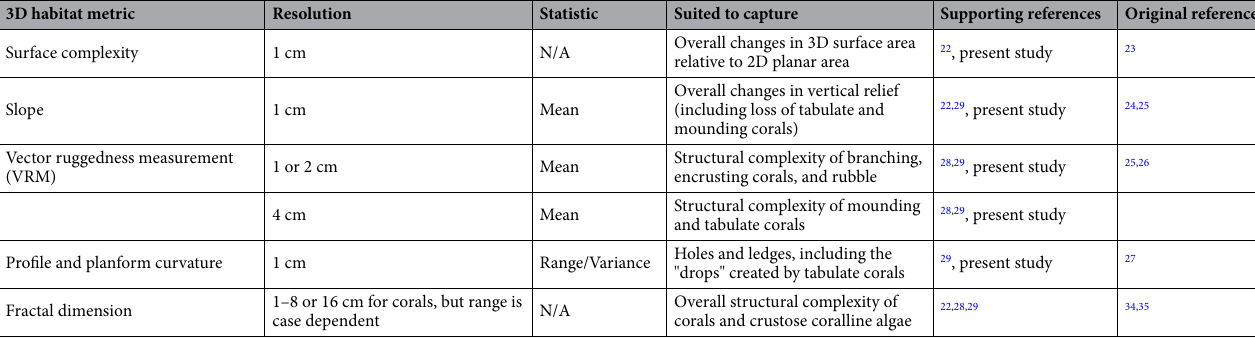
Table 3. Summary table showing properties of different habitat metrics that are recommended for characterization of coral-reef habitats. Listed are the recommended habitat metrics and resolutions, statistic (n/a means that there is only a single value produced per DEM), suitable benthic features to capture, references that support this recommendation, and original references of each